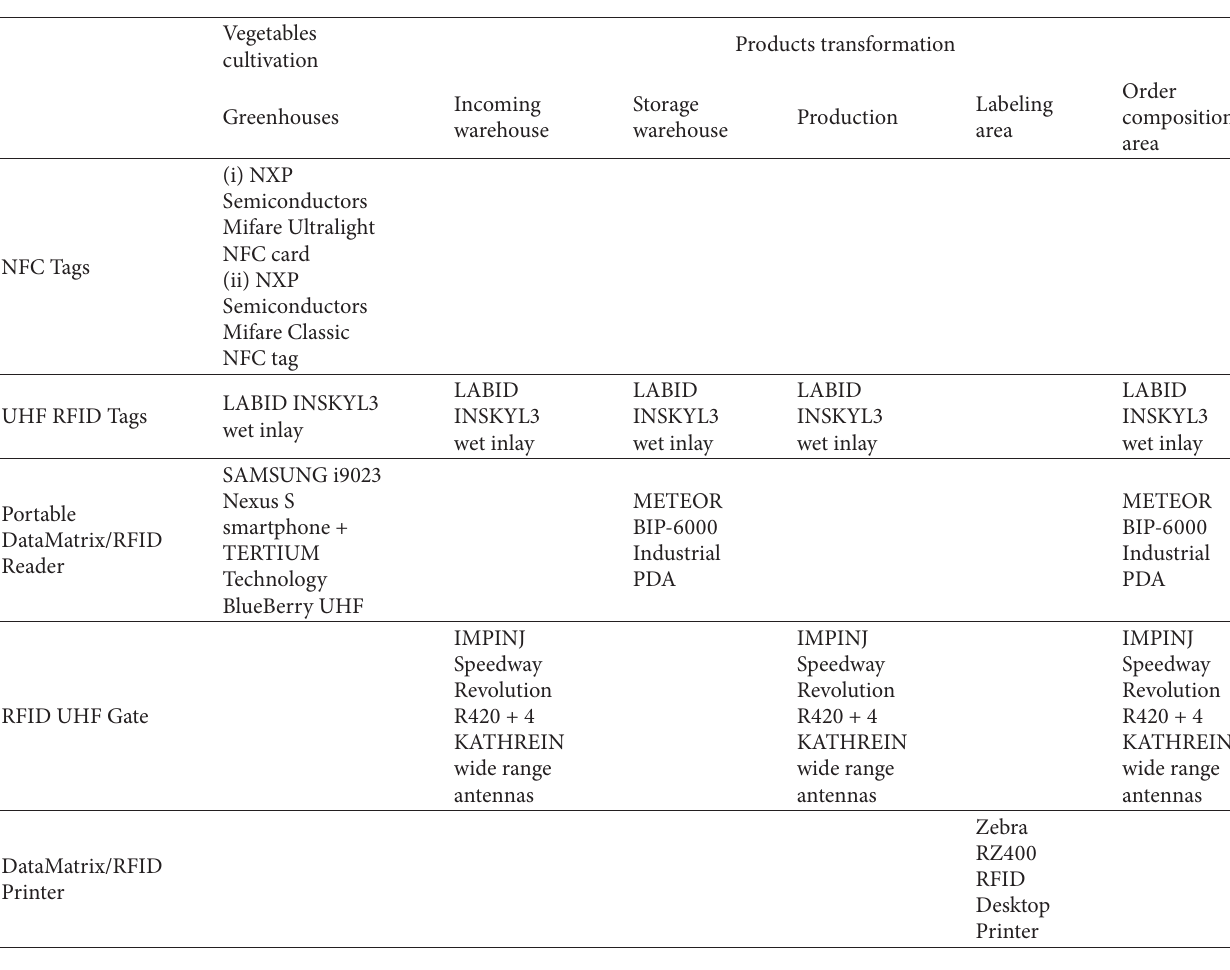
Table 2: Devices used in the pilot project.